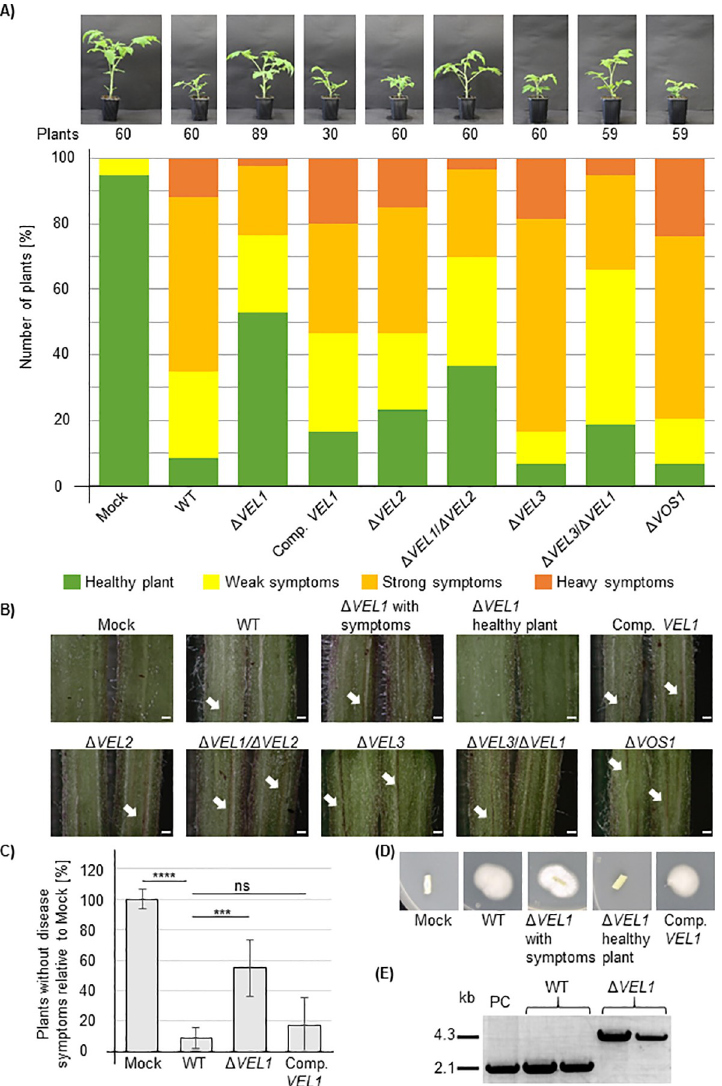
Fig 6. V . dahliae requires Vel1 to induce disease symptoms in tomato plants. Tomato plants were grown for 10 days and inoculated by root dipping with the same amount of fungal spores of V . dahliae wild type and indicated mutant strains defective in genes for velvet domain proteins or a VEL1 complementation strain. The mock control was treated with demineralized water. Single experiments included at least 14 plants and two different transformants for each deletion and double deletion strain were used. Each strain was analyzed in at least two independent experiments. (A) Disease symptoms were scored after 21 days (16 h, 25˚C: 8 h, 22˚C, light: dark). Measurements included heights of plants until the vegetation point, length of the biggest leaf and fresh weight of aerial plant parts. Parameters were calculated into a disease score leading to the categories healthy plant, weak symptoms, strong symptoms and heavy symptoms. The diagram shows the relative number of plants of each category and a representative plant for each strain. Mock treated plants were mostly healthy with some plants with weak symptoms. More than 60% of plants inoculated with wild type developed heavy or strong disease symptoms. (B) Images of hypocotyl cross sections with arrows indicating discolorations, which are not found in uninfected plants and in approximately 40% of plants treated with the Δ VEL1 strain. Scale bar = 500 μ m. (C) Quantification of plants without disease symptoms. Means and error bars represent the standard deviation and mean of two independent experiments including at least 14 plants and at least two deletion strains. Significant differences calculated by t-test are indicated: ��� :p < 0.001; ���� :p = 0.0001; ns: not significant. (D) Fungal growth from stem sections of tomato plants. Stems of tomato plants treated with indicated V . dahliae strains were surface sterilized and incubated for seven days at 25˚C on PDM plates supplemented with chloramphenicol (34 μ g/ml). Wild type as well as VEL1 complementation strain could be re-isolated from the stem. The VEL1 deletion strain could only be re-isolated from plants displaying disease symptoms. (E) Verification of isolated fungal strains by PCR. Fungal material isolated from plate was inoculated in PDM for mycelia